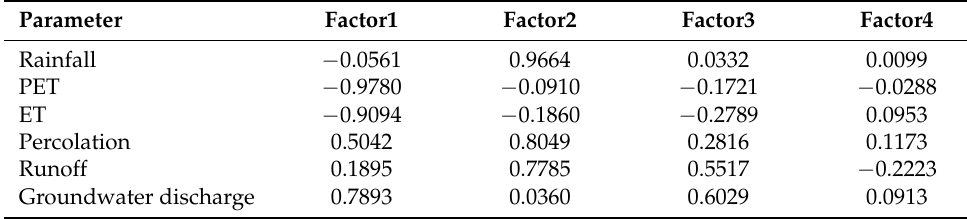
Table 3. Rotated factor correlation coefficients from principal factor